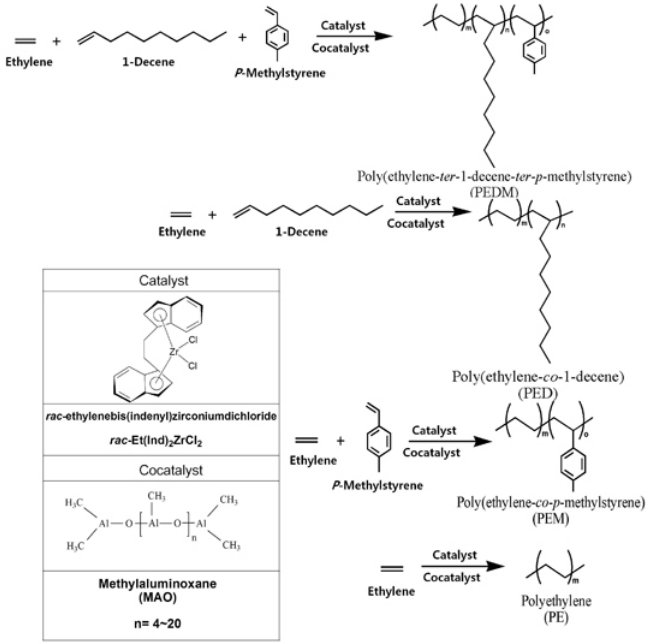
Figure 1. Scheme for the synthesis of homo-, co- and ter-polymer.